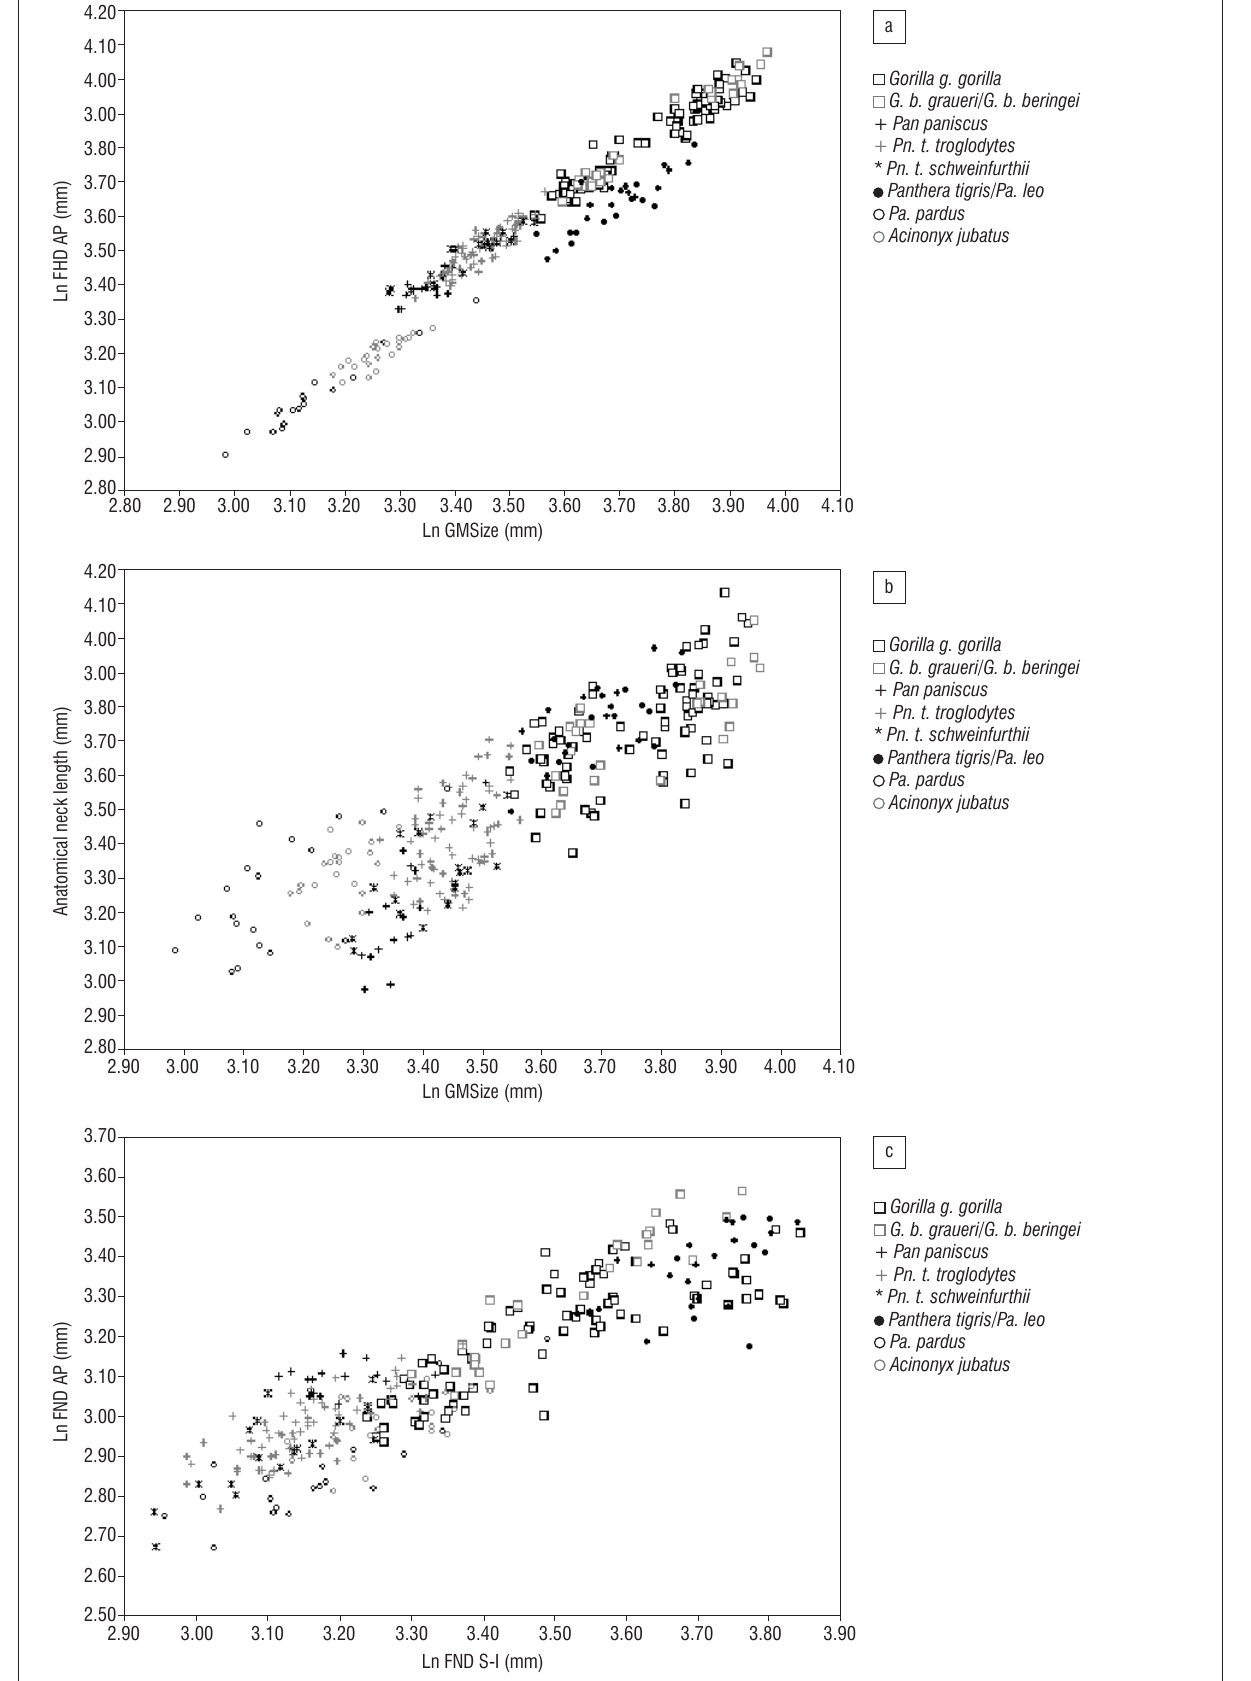
Figure 4: Bivariate scatter plots of selected parameters versus GMSize: (a) femoral head diameter (anterior to posterior); (b) anatomical neck length of the femur and (c) femoral neck (anteroposterior diameter versus superoinferior